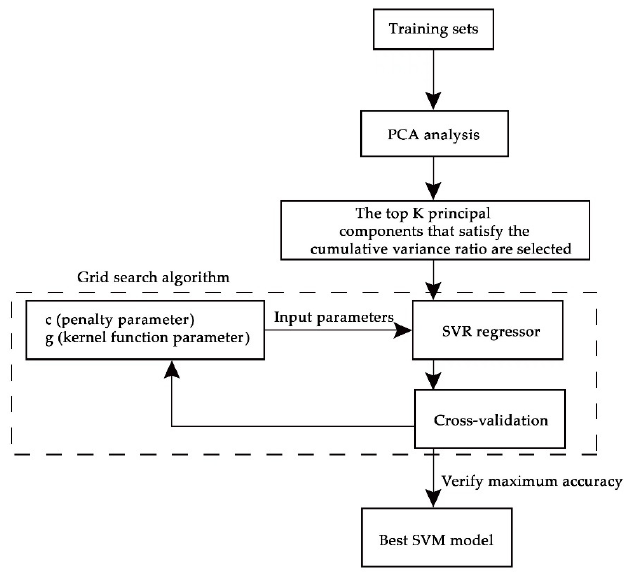
Figure 3. Operational process of the PCA–SVR coupling algorithm.